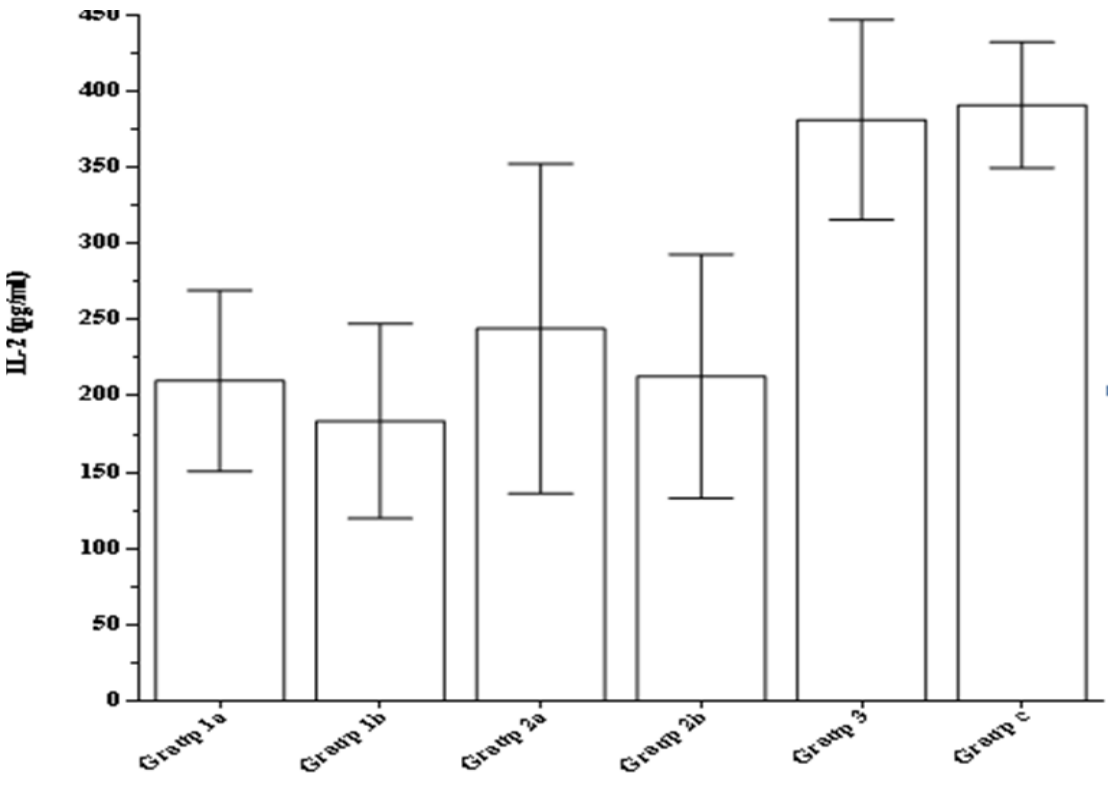
Figure 1. Plasma levels of IL-2 in group 1a, group 1b, group 2a, group 2b, group 3 and group c. Bars represent mean standard deviation.